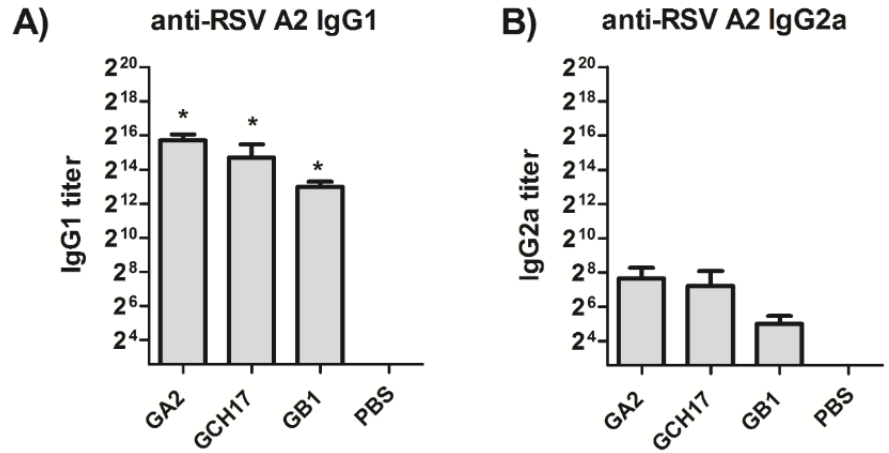
Figure A2. Humoral response induced by LbL nanoparticle vaccination. Mice were vaccinated with LbL nanoparticles on day 0 and 21. At day 35 post vaccination serum was collected and RSV-specific antibody isotypes IgG1 ( A ) and IgG2a ( B ) levels were measured via indirect ELISA assay. Experiments were independently repeated at least 3 times and analyzed by one-way ANOVA test. * p < 0.05 compared to PBS, values are shown as the mean ±